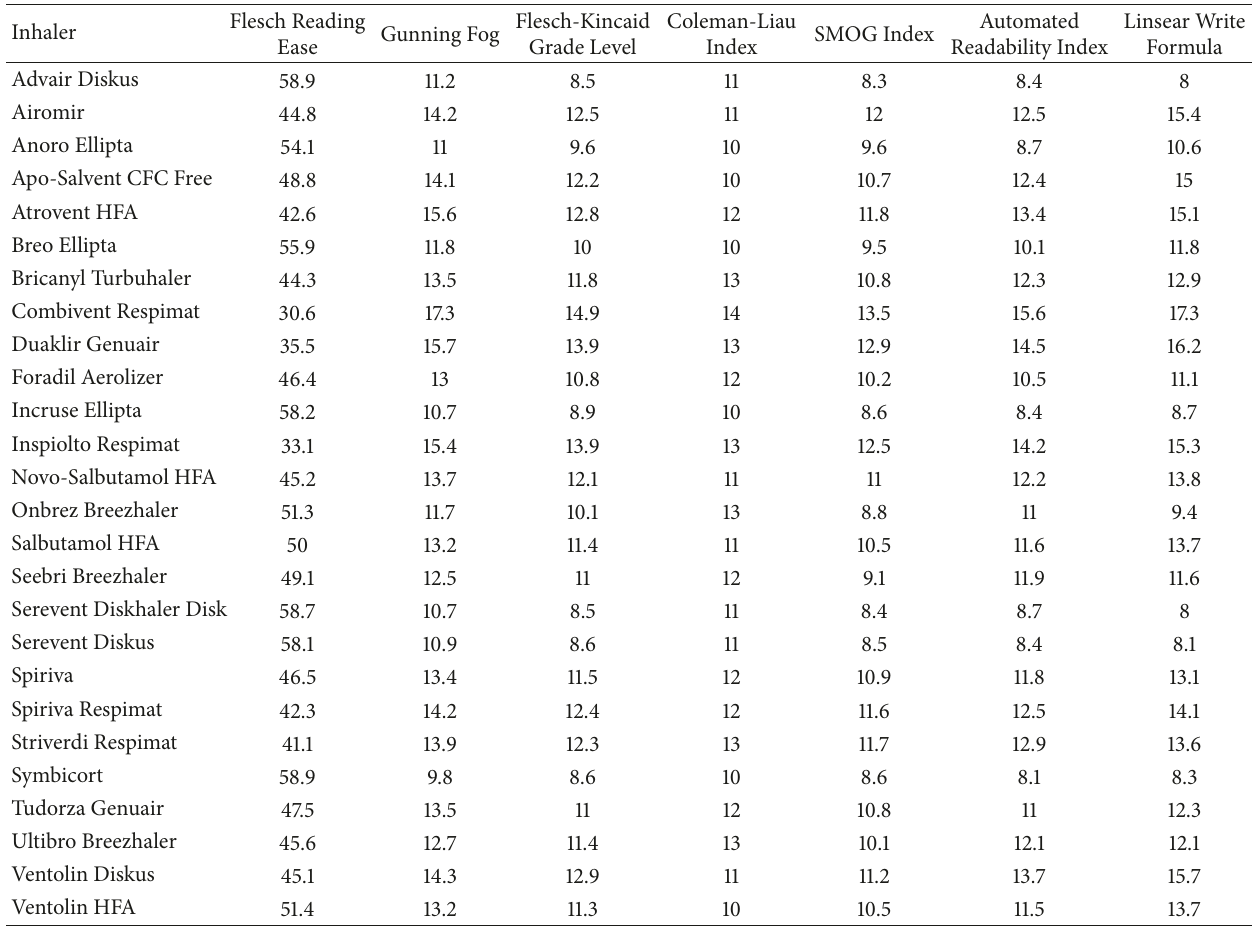
Table 4: Readability of patient medication